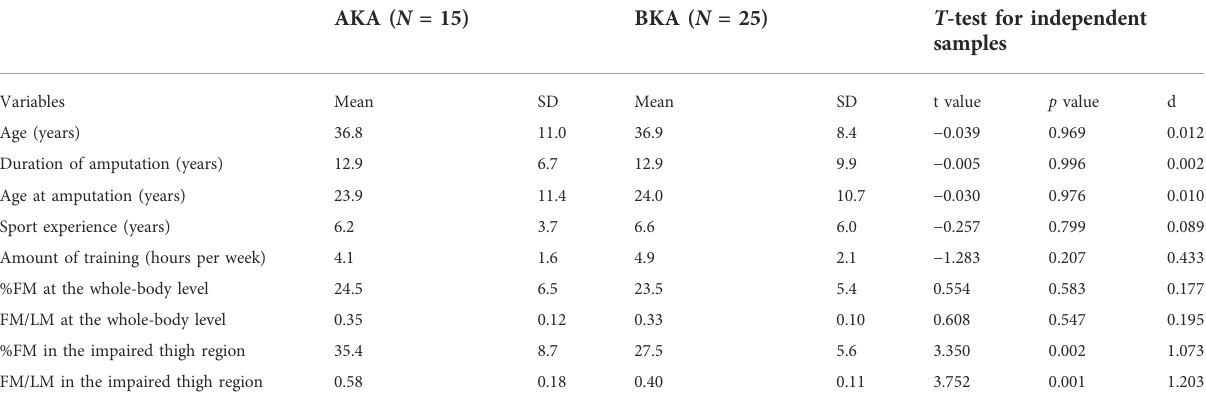
TABLE 1 General characteristics of the AKA and BKA groups. Data are mean ± standard